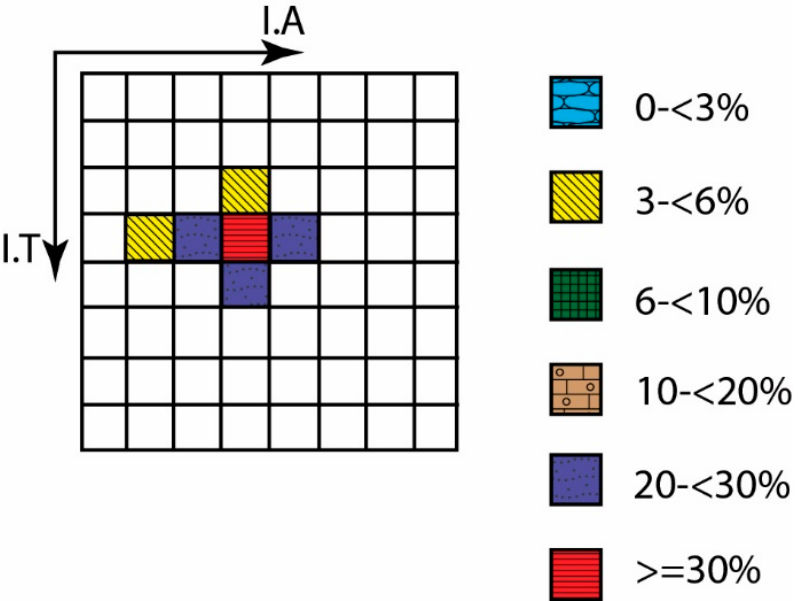
Figure 13. Typological distribution diagram of zircons from biotites of Ari el Mahsar rhyolitic dome.